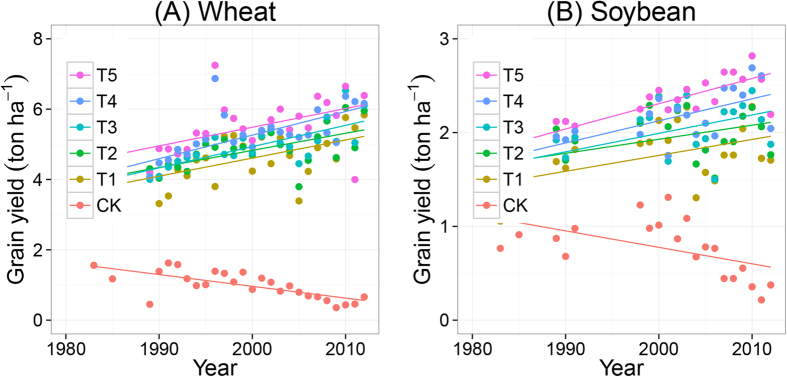
Trends of wheat (A) and soybean (B) yields over time during the period 1982–2012, as function of fertilization treatments. The treatments are noted as: no fertilization (CK), mineral NPK (T1), NPK + low rate of straw (T2), NPK + high rate of straw (T3), NPK + pig manure (T4) and NPK + cattle manure (T5). Statistics are summarized in Table 4.